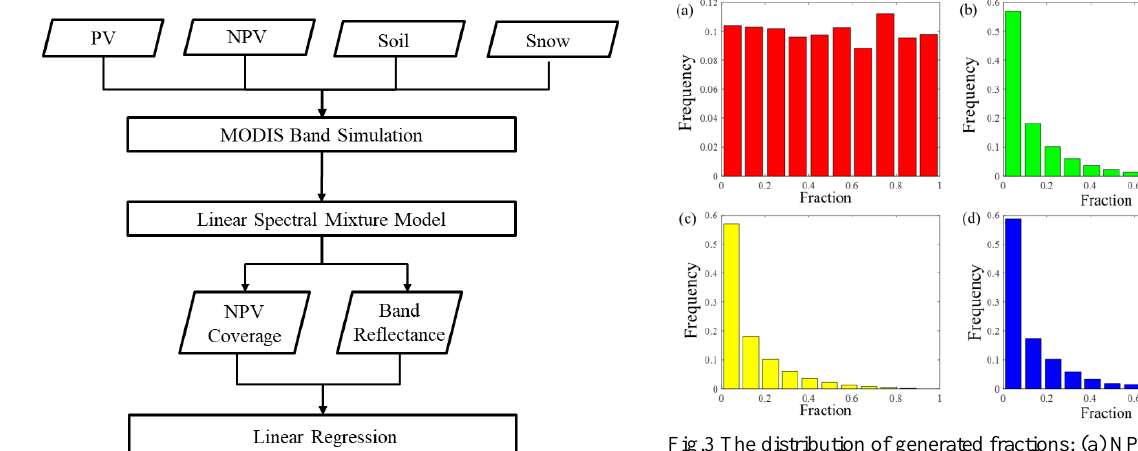
Fig.1 Development of NPVI